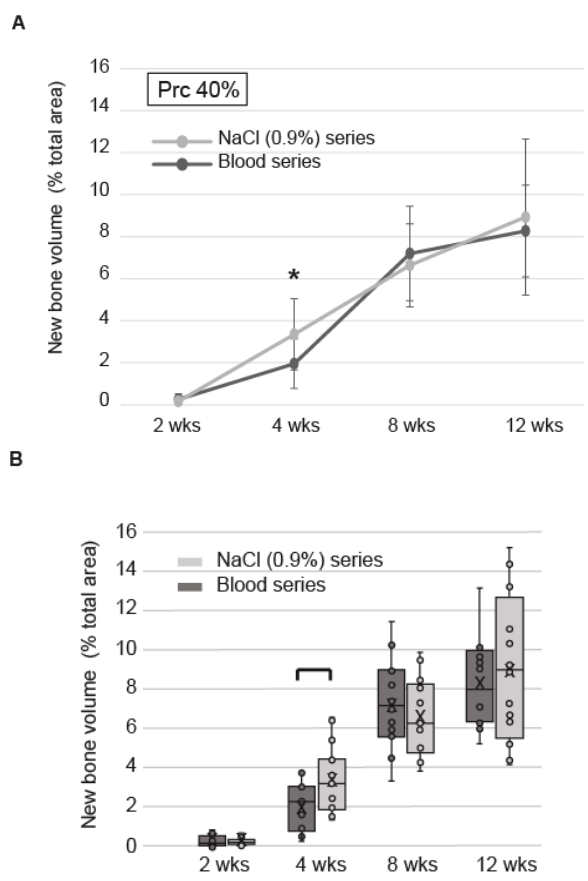
Figure 5. Histomorphometry ( A ) New bone volume in the cylinders filled with DBBM-C scaffolds either pre-treated with blood (dark grey) or NaCl 0.9% (light grey) at 2, 4, 8 and 12 wks. Data are expressed as mean ± SD, *: significantly different ( p < 0.05) (n = 6 per treatment at each time point). ( B ) Box plots showing the new bone volume in the cylinders filled with DBBM-C scaffolds either pre-treated with blood or NaCl 0.9% at 2, 4, 8 and 12 wks. Horizontal line: median; Boxes: 25–75%; ×: mean; Bars: range of non-outliers. Brackets: significantly different ( p < 0.05).